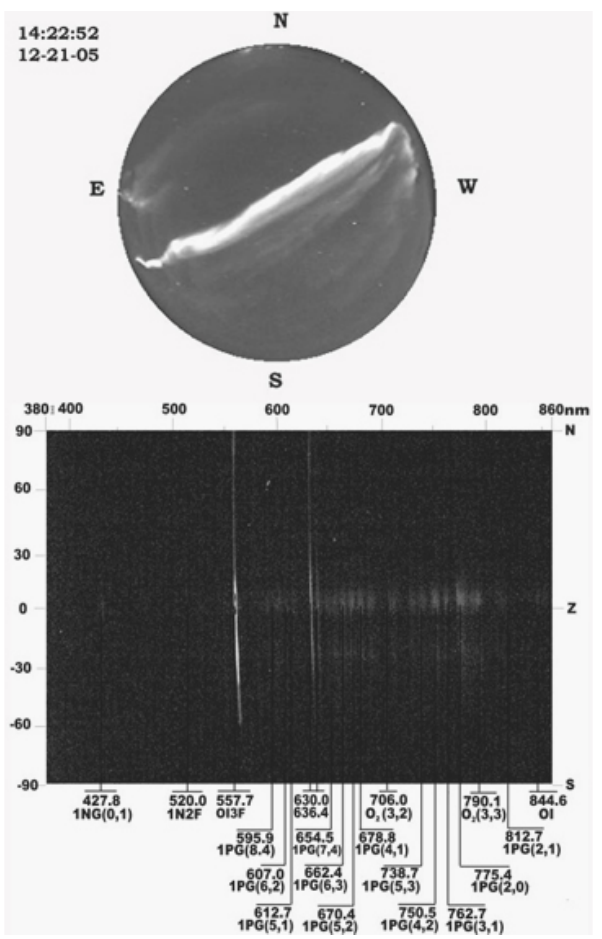
Fig. 3. Example of an auroral spectrum registered by CCD spec- tral camera with 1-min exposure (lower panel) and auroral image registered by the TV (SIT) camera in Barentsburg (upper panel).